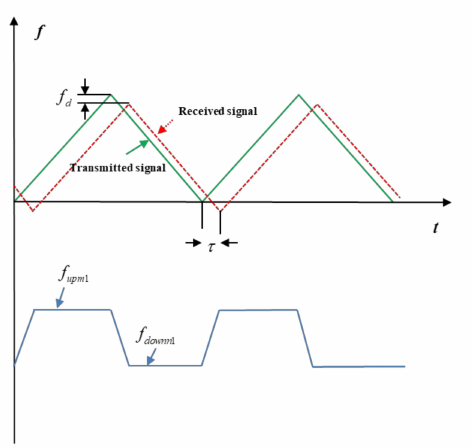
Figure 2. Schematic diagram of triangular FMCW ranging with primary vibration